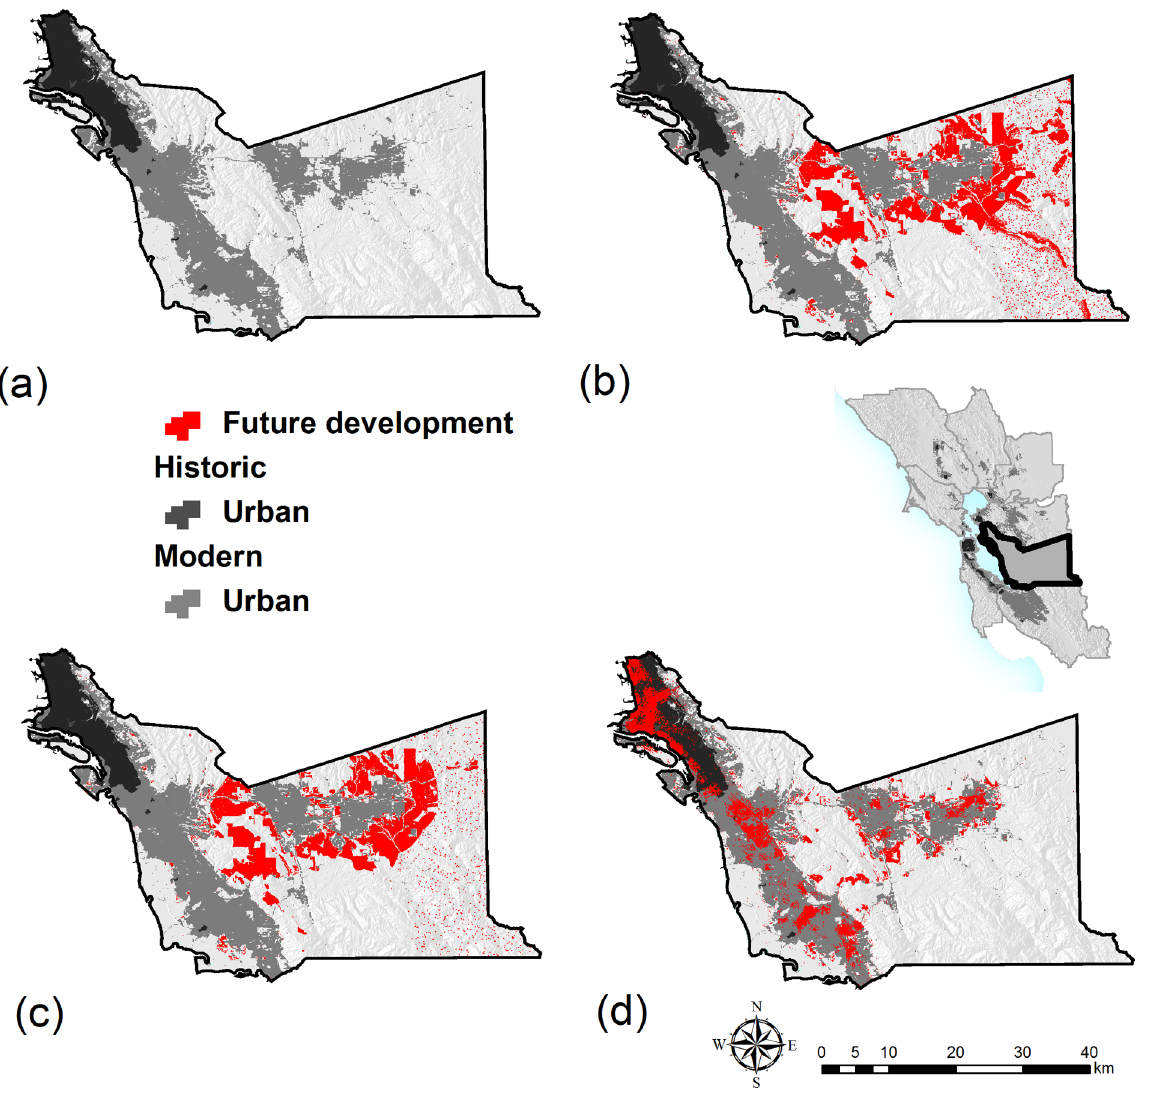
Figure 3. A detail of urban development trends and projections for Alameda County. (a) dark grey – Historic urban extents in 1940 and light grey – Present urban extent in 2011; (b) Future urban growth by 2050 Business-as-usual scenario (red); (c) Future urban growth by 2050 Smart Growth scenario and (d) Future urban growth by 2050 Infill scenario.